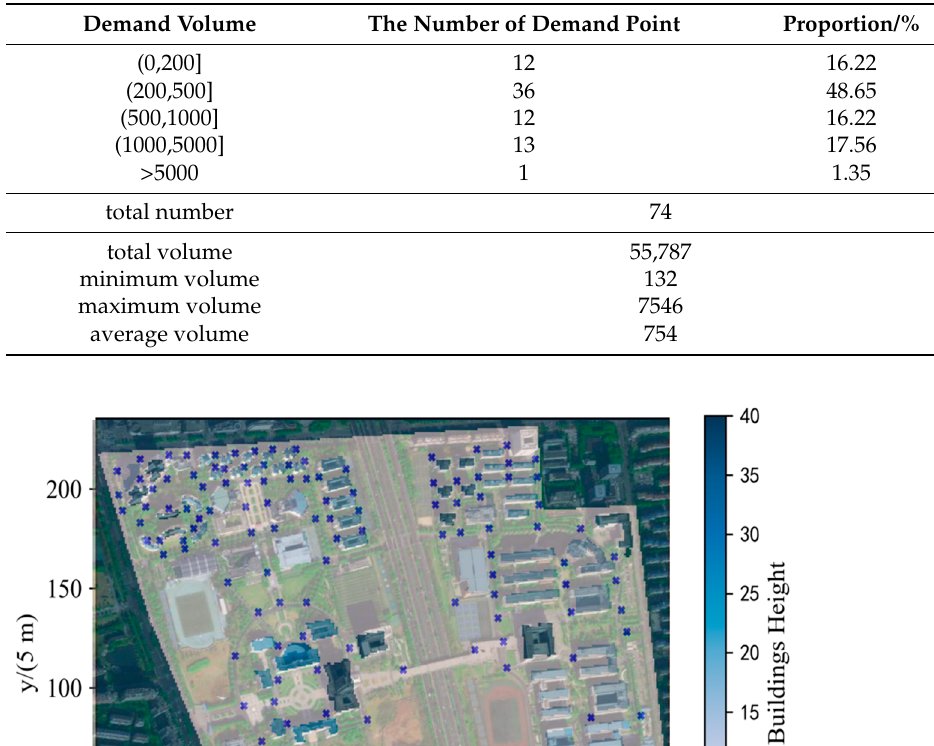
Figure 10. Alternative locations of the package-receiving station. Table 5. Distribution and volume of logistics demand.